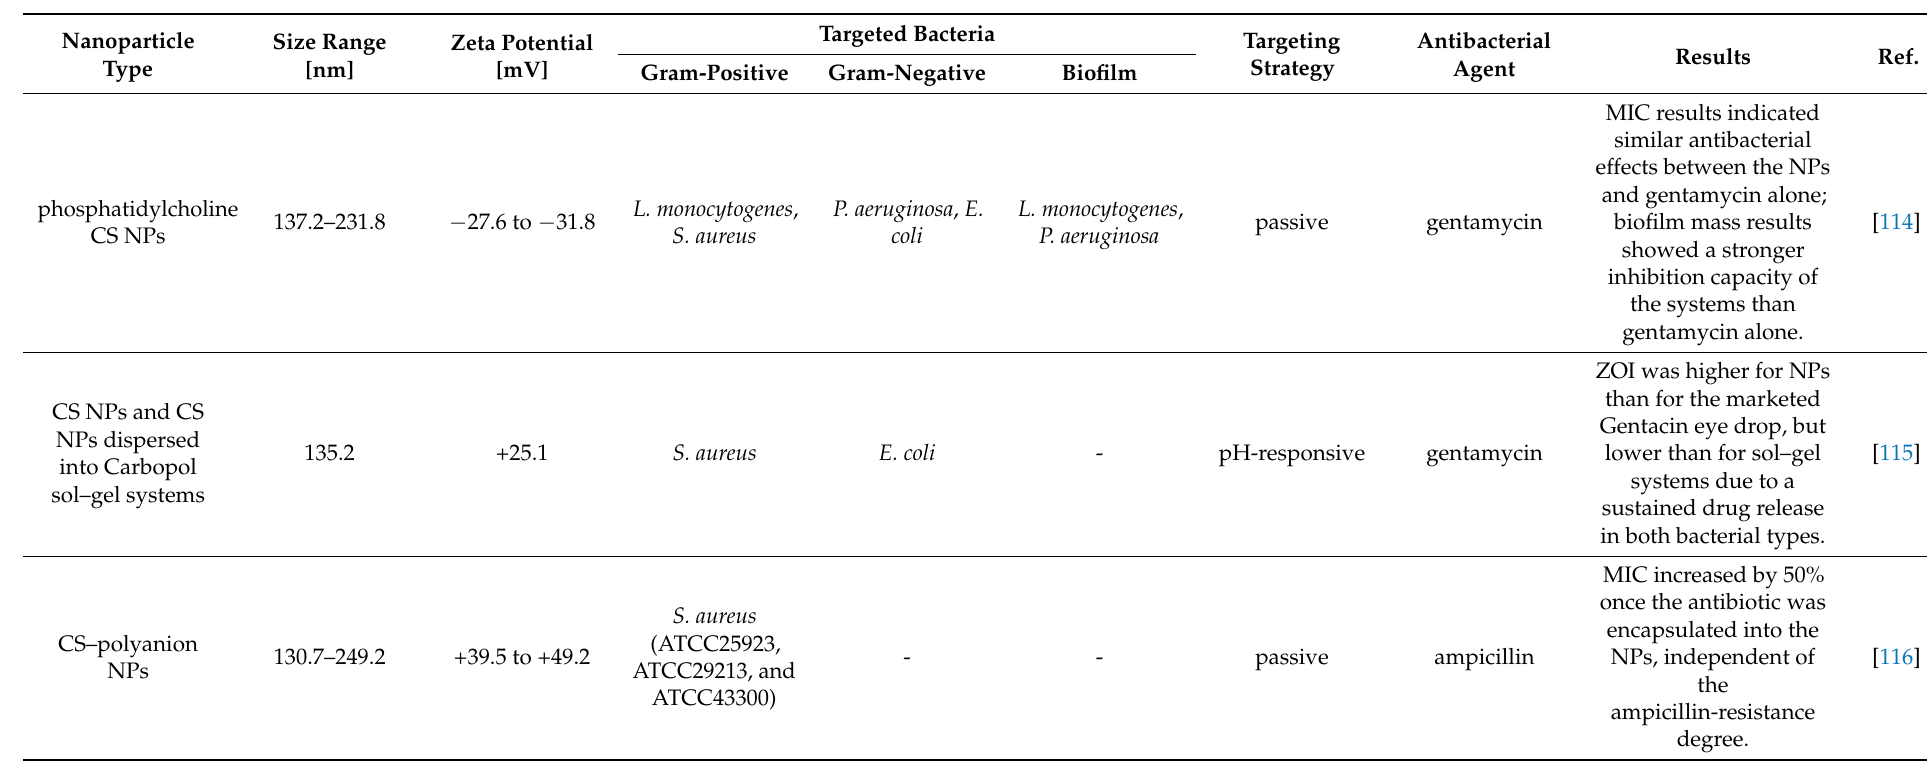
Table 1. Summary of the identified studies investigating the antibacterial properties of nanoparticles synthesized from natural